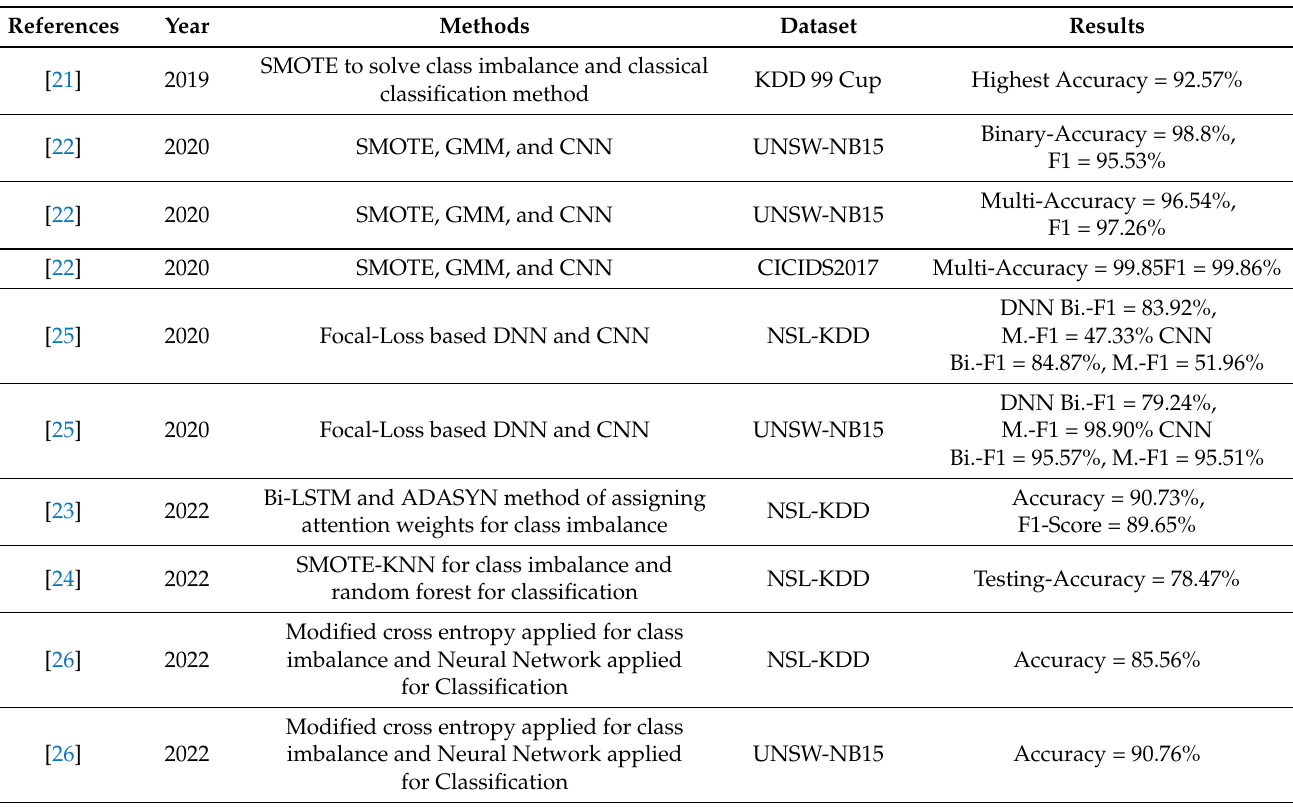
Table 1. Summary of recently applied NIDS studies using class imbalance problem